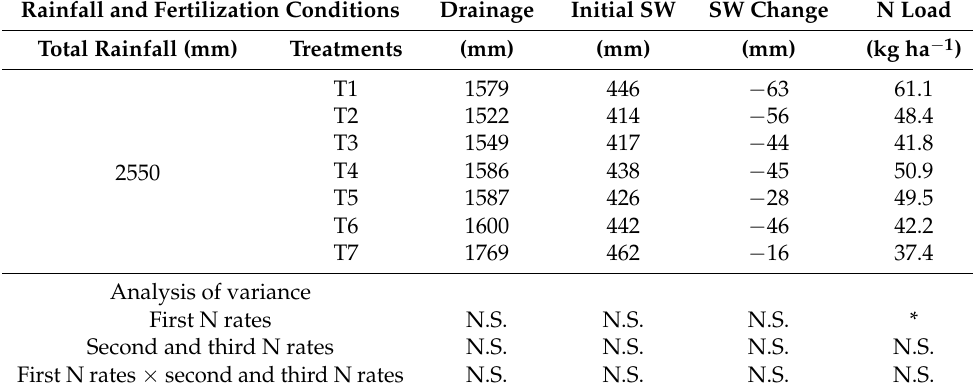
First N rates × second and third N rates N.S.